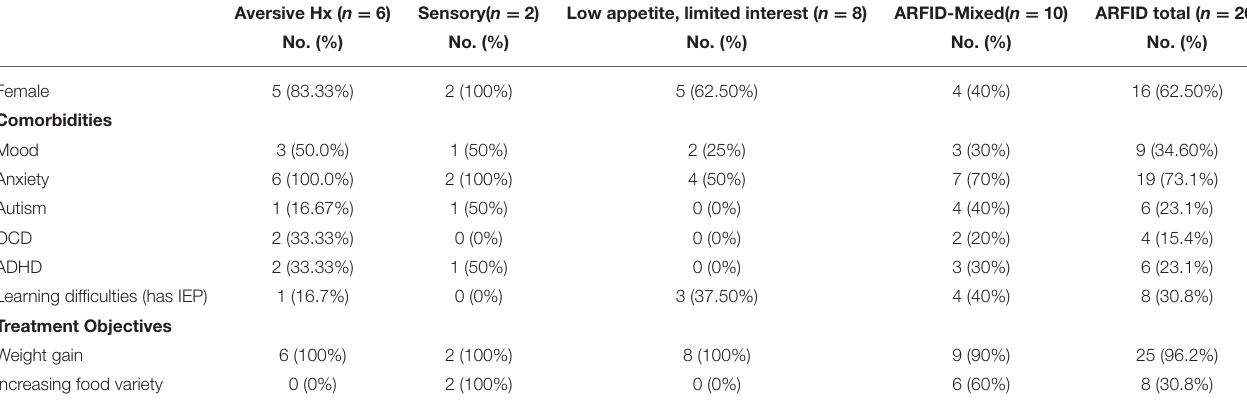
TABLE 2 | Sex, comorbid psychological diagnoses, and treatment objectives for pediatric ARFID patients ( n = 26) admitted to a specialized pilot clinic. Aversive Hx ( n =